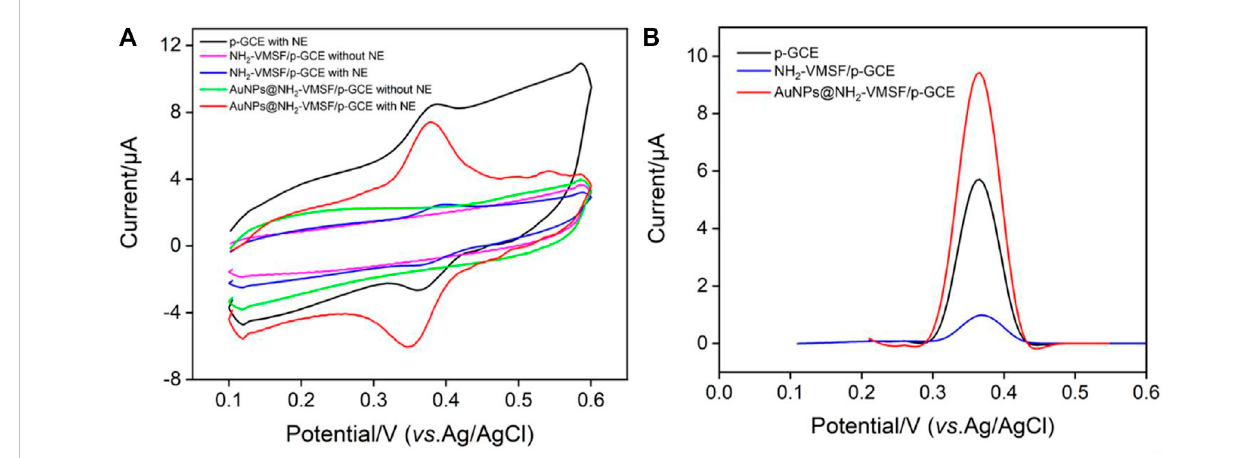
FIGURE 3 (A) CVcurvesobtainedatdifferentelectrodesinPBS(0.1M,pH=5)withoutorwithNE(10 μ M). (B) DPVcurvesobtainedatdifferentelectrodesinNE (10 μ M) solution in PBS (0.1 M, pH =